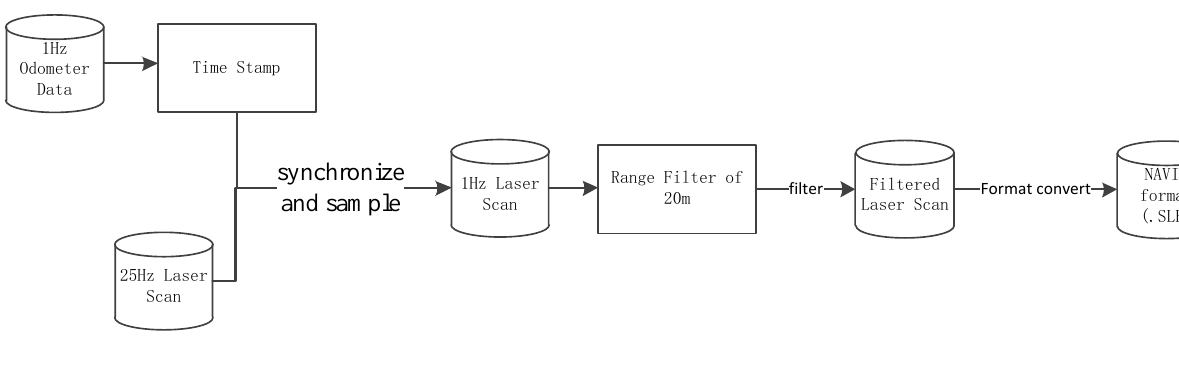
Figure 9. The flow chart of the laser data